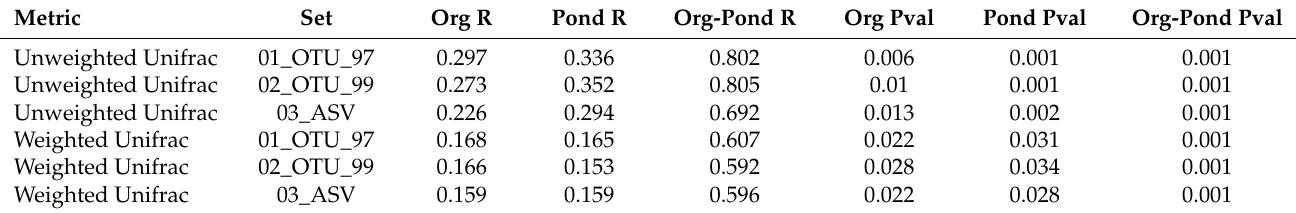
Table 1. ANOSIM results for group comparisons with phylogenetic-based composition and abundance